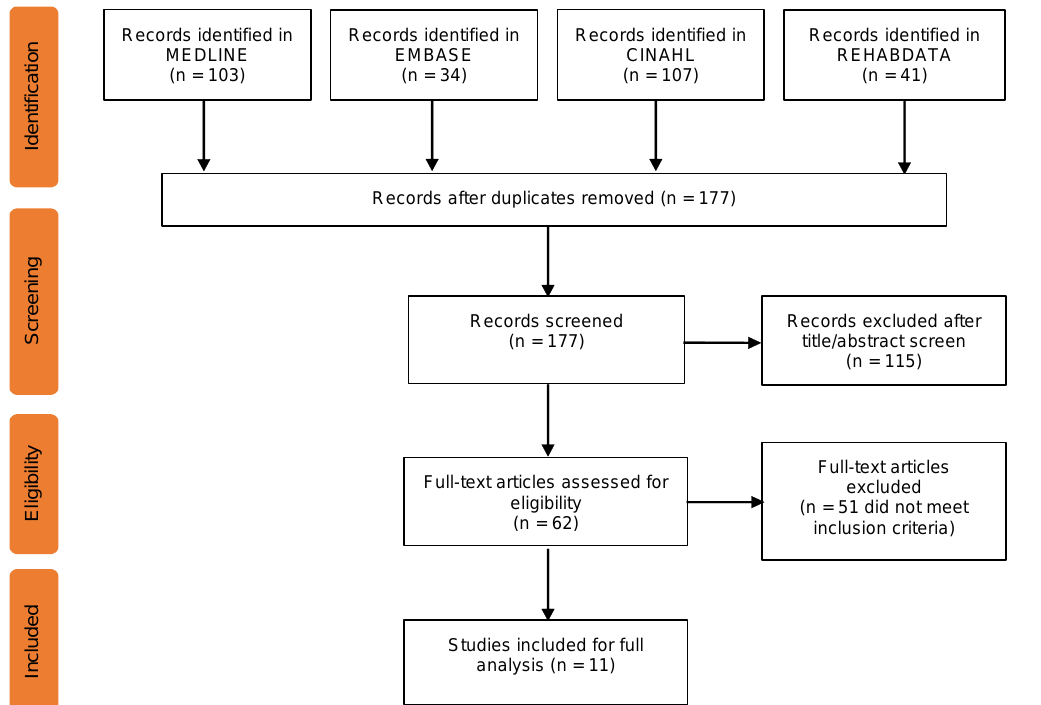
Figure 2: Flowchart diagram of the literature search, screen and selection